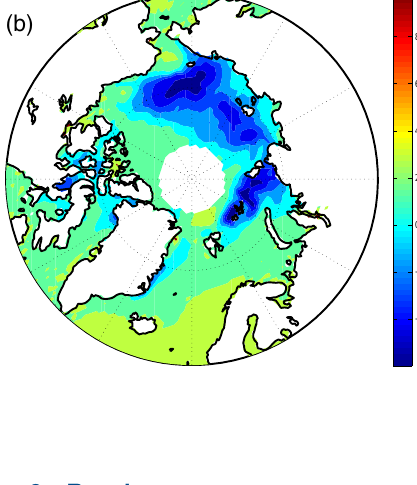
graphic projection, is 25 × 25 km 2 . The second dataset